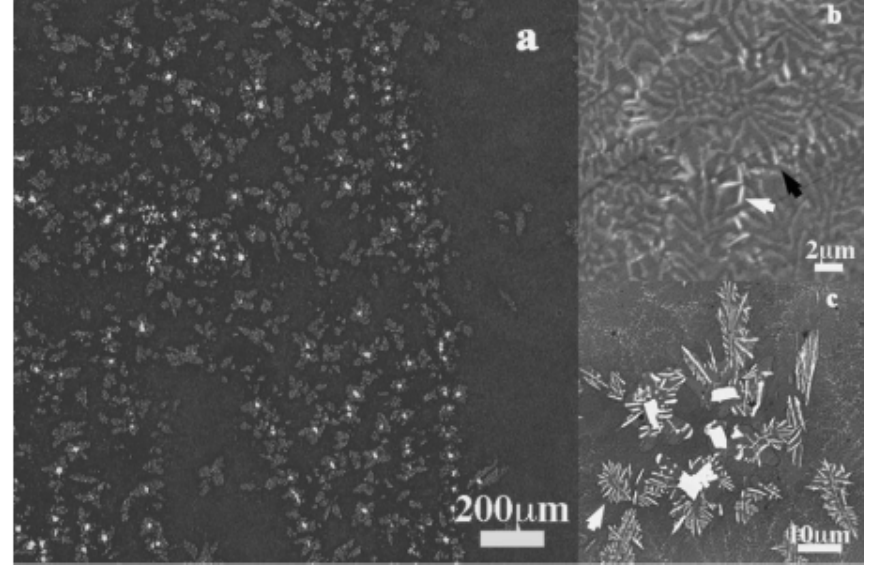
Figure 2. ( a ) SEM-BEI micrographs of Fe levitation; ( b ) Needle-like phase in the eutectic microstructure; ( c ) Plate-like crystals and dendrites embedded in the eutectic